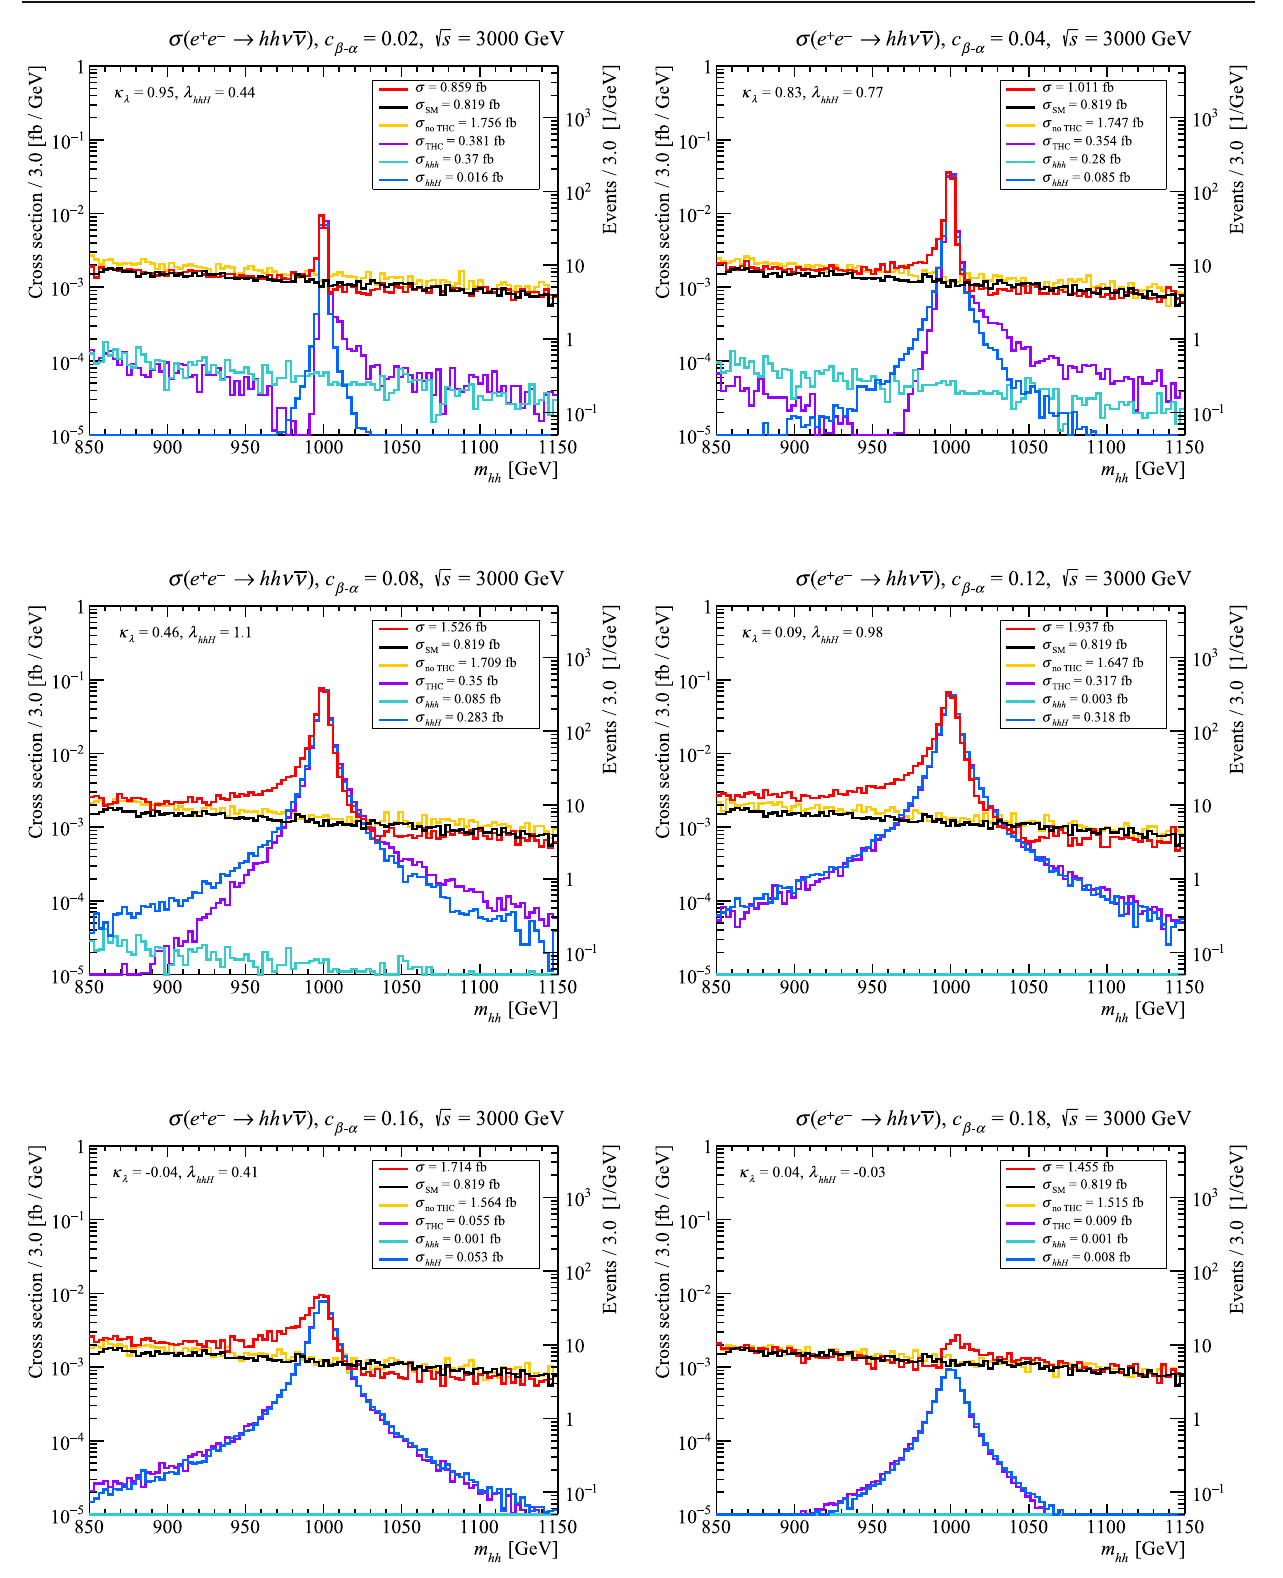
Fig. 26 Evolution with c β − α in benchmark point 4 of the invariant mass of the final hh pair around the mass of the H boson in the process √ e + e − → hh ν ¯ ν at s = 3000